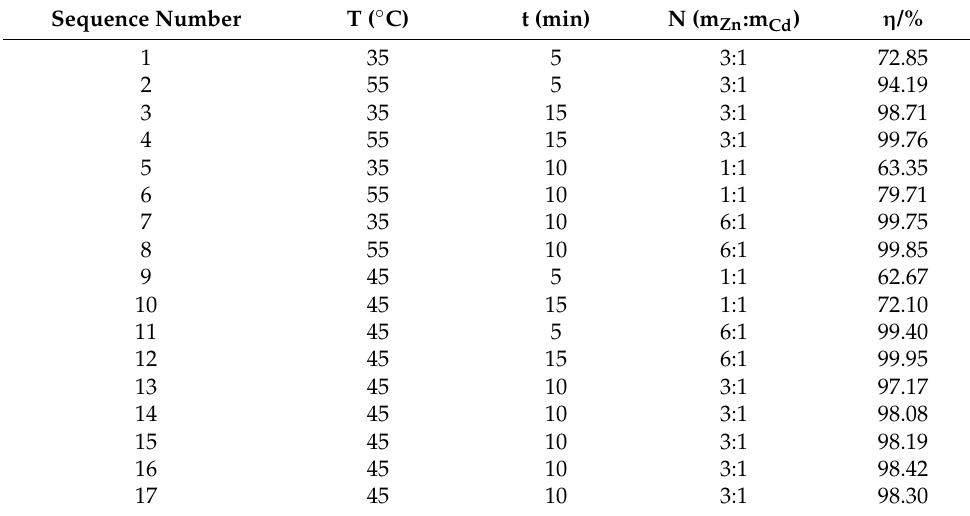
Table 2. Experimental scheme and results of the Cd removal rate.